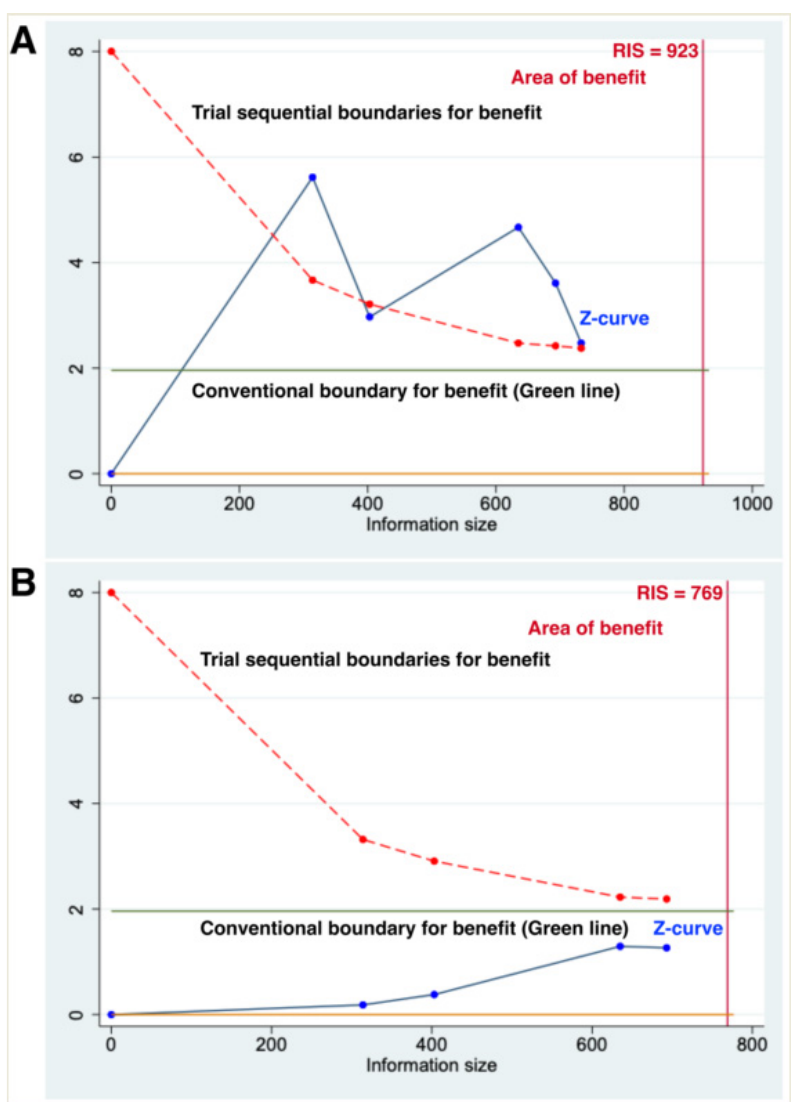
Figure 3. Trial sequential analysis (TSA) of primary outcomes regarding ( A ) progression-free survival and ( B ) overall survival. X axis indicates the information size referring to cumulative patient numbers; Y axis indicates the Z-score; green horizontal lines indicate conventional boundaries; red sloping lines at the top left-hand corners indicate the trial sequential boundaries as the TSA threshold for statistical significance. Red vertical full line indicates the required information size (RIS). Blue solid line indicates the cumulative Z-curve. ( A ) Trial sequential analysis of progression-free survival. The cumulative number of patients did not exceed the number of 923 patients, but the Z-curves surpassed the significance boundary in favor of lenalidomide maintenance therapy, suggesting a conclusive result. ( B ) Trial sequential analysis of overall survival. The cumulative patient numbers did not surpass the required patient number of 769, and the Z-curves did not surpass any significance boundary, indicating an inconclusive result of